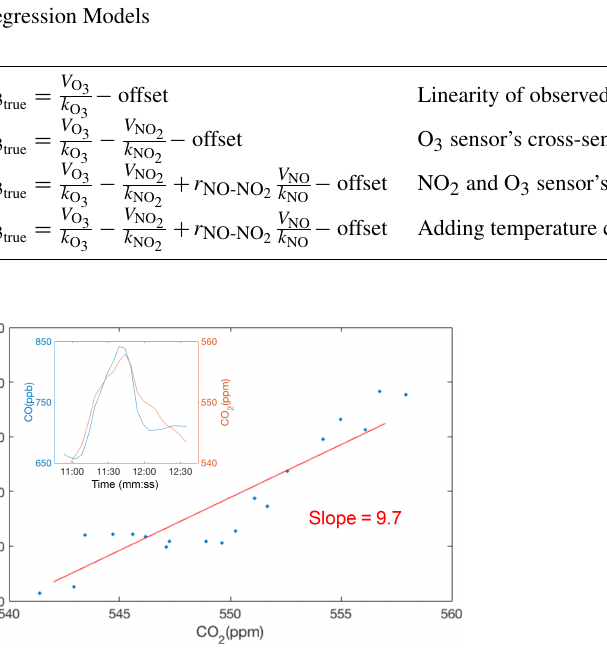
Figure 4. Example of CO plume identification and regression against CO 2 to find the CO emission factor using raw, 10s data. The derived CO emission ratio (CO / CO 2 ) for this example is 9.7ppbppm − 1 .